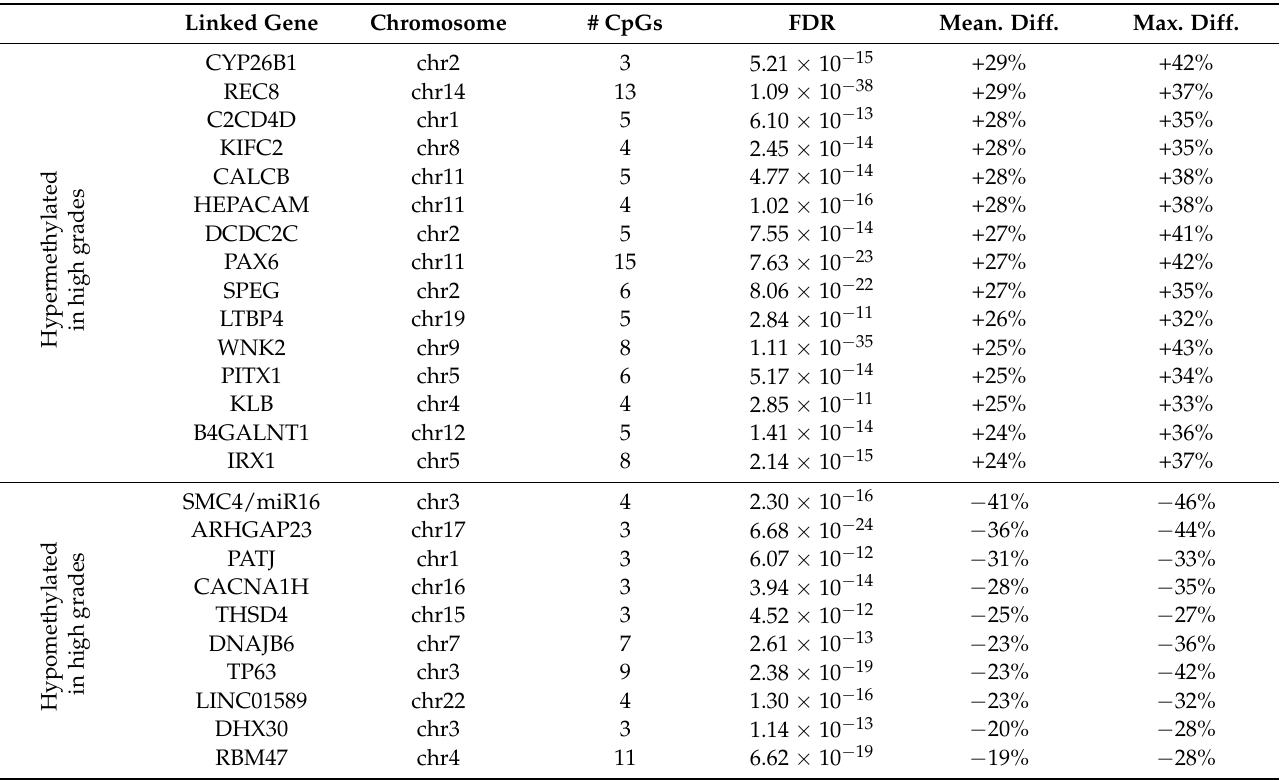
Table 3. Top differentially methylated regions (DMRs; 15 hypermethylated, 10 hypomethy- lated) ordered by average methylation differential (Mean Diff.) between high-grade (2, 3) and low-grade (1) meningiomas.